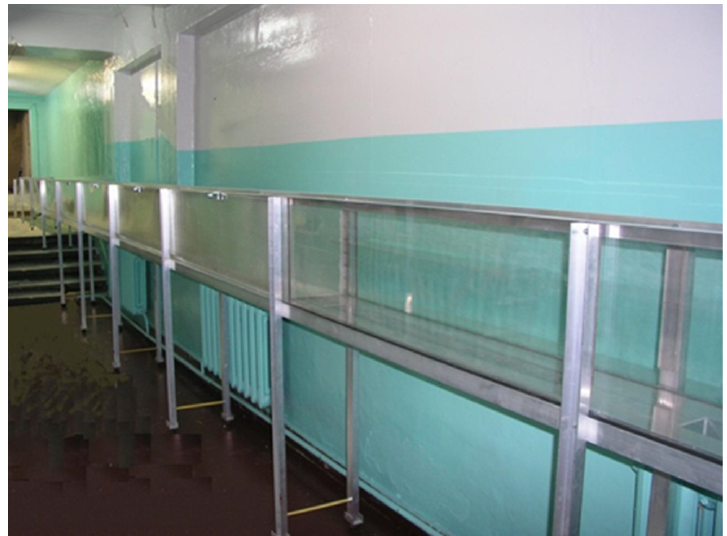
Figure 1. The hydrodynamic channel (wave flume) of the IPRIM RAS.